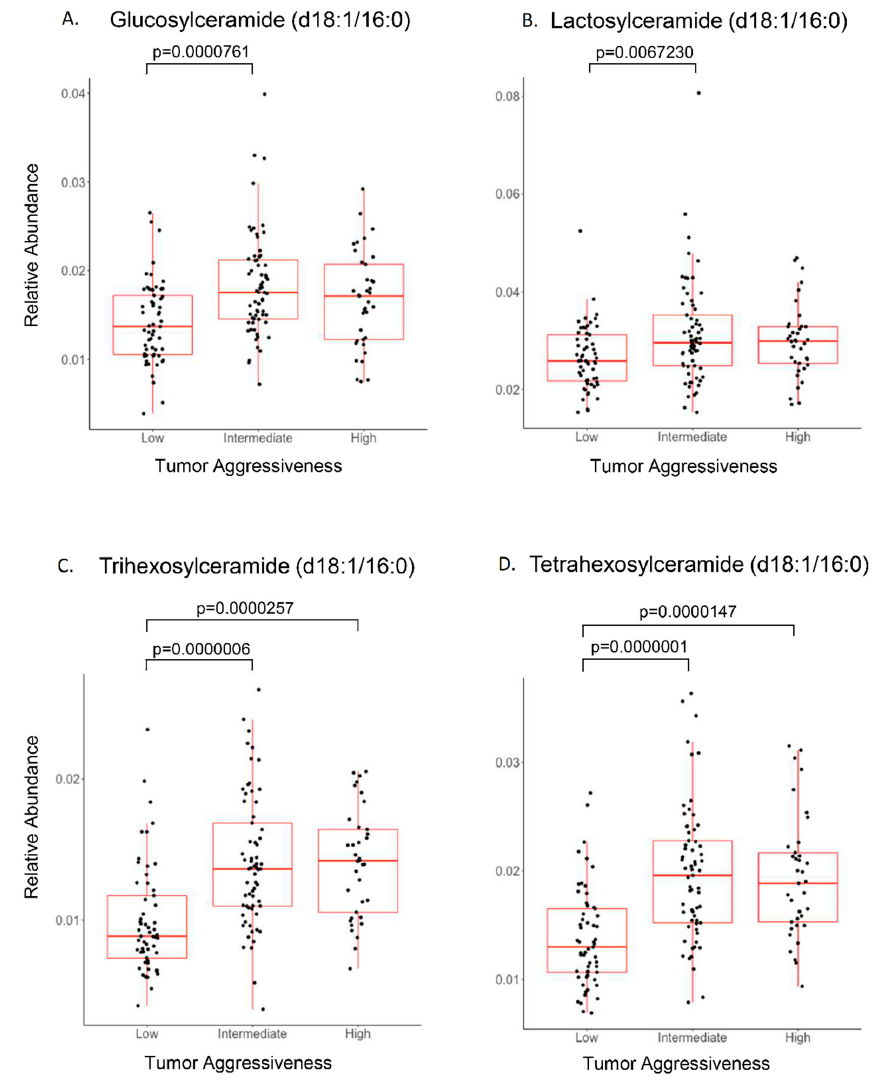
Figure 3. Sphingolipid association with PCa aggressiveness. PCa plasma samples were stratified for low-, intermediate-, and high-aggressive scores (PCaP assigned) and analyzed (ANOVA) for individual sphingolipids. ( A ) Glucosylceramide and ( B ) lactosylceramide were elevated significantly in intermediate-aggressive PCa samples. ( C) Trihexosylceramide and ( D ) tetrahexosylceramide were elevated significantly in both intermediate- and high-aggressive PCa